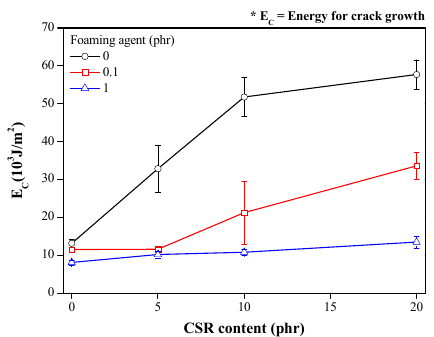
Figure 8. Energy for crack growth of CSR/epoxy composite foam adhesives.